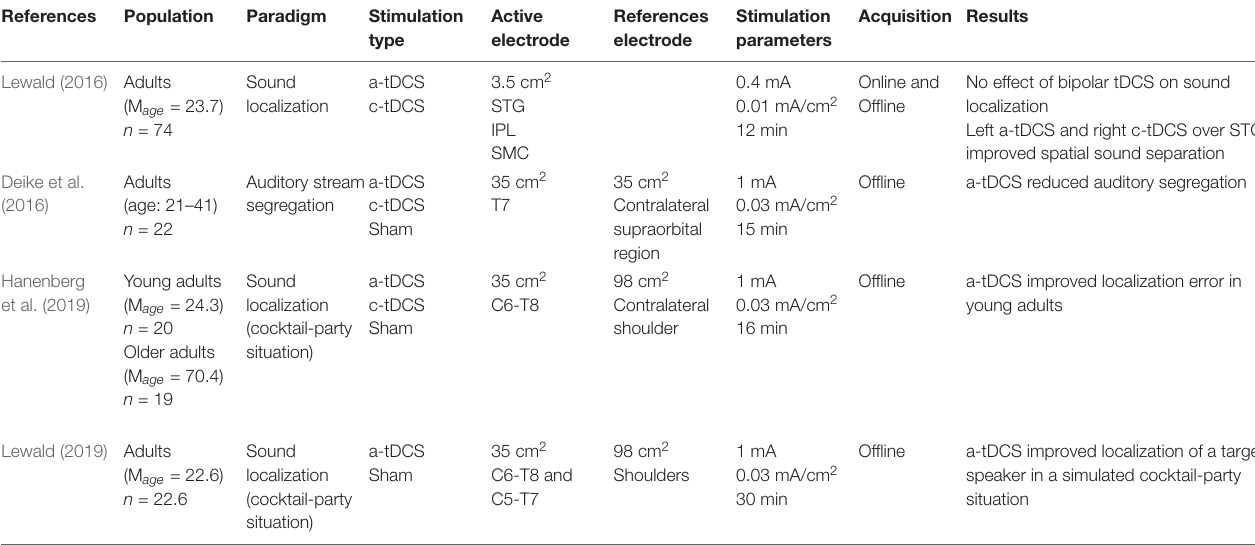
TABLE 5 | Auditory scene